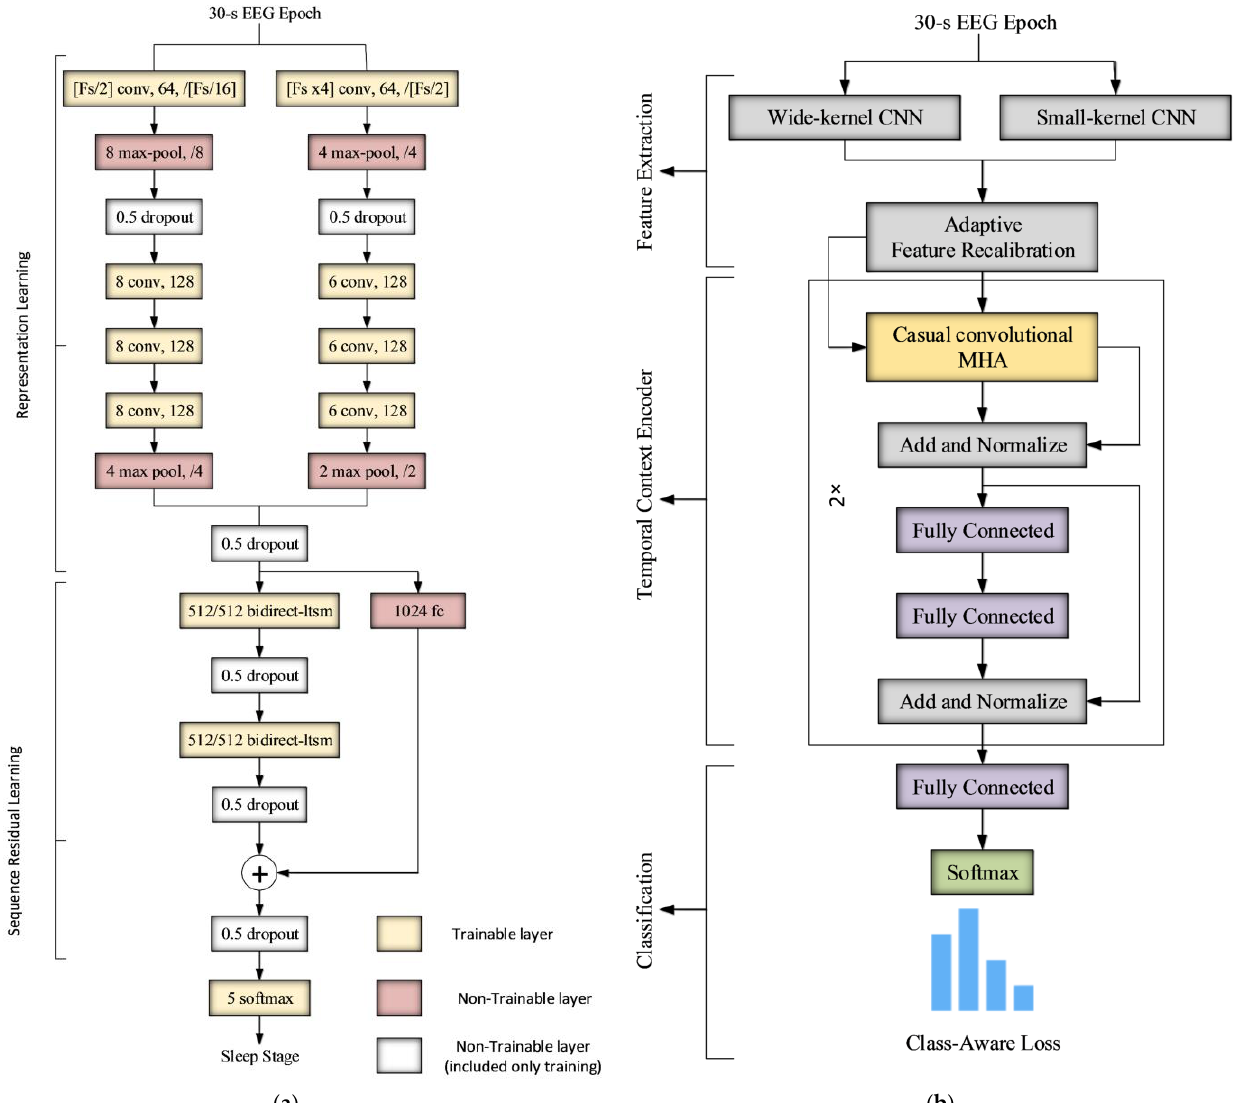
Figure 2. The architecture of the ( a ) DeepSleepNet and ( b ) AttnSleep sleep stage scoring systems.